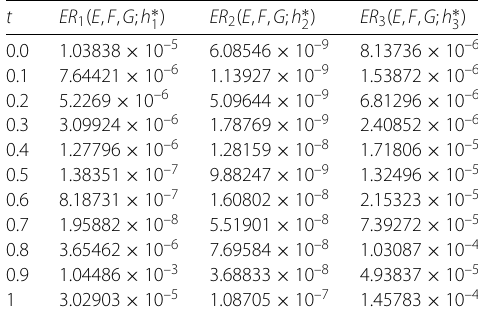
Figure 8 The residual errors function Eq. (24) using the 6th-order approximation solution for various h = –0.9, h = –1, h = optimal, h = –1.1 and t ∈ (0,1)